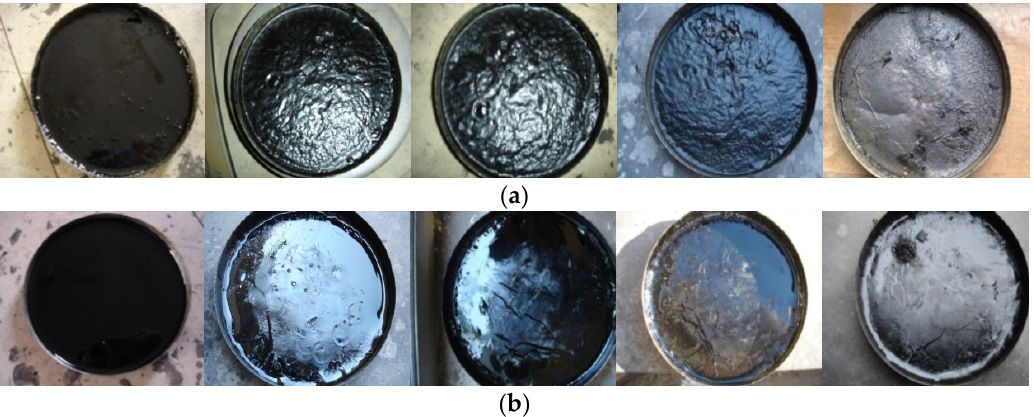
Figure 10. Appearance comparison after UV aging (0, 8, 12, 24, 48 h); ( a ) LS pre-maintenance agent; ( b ) Rhinophalt.